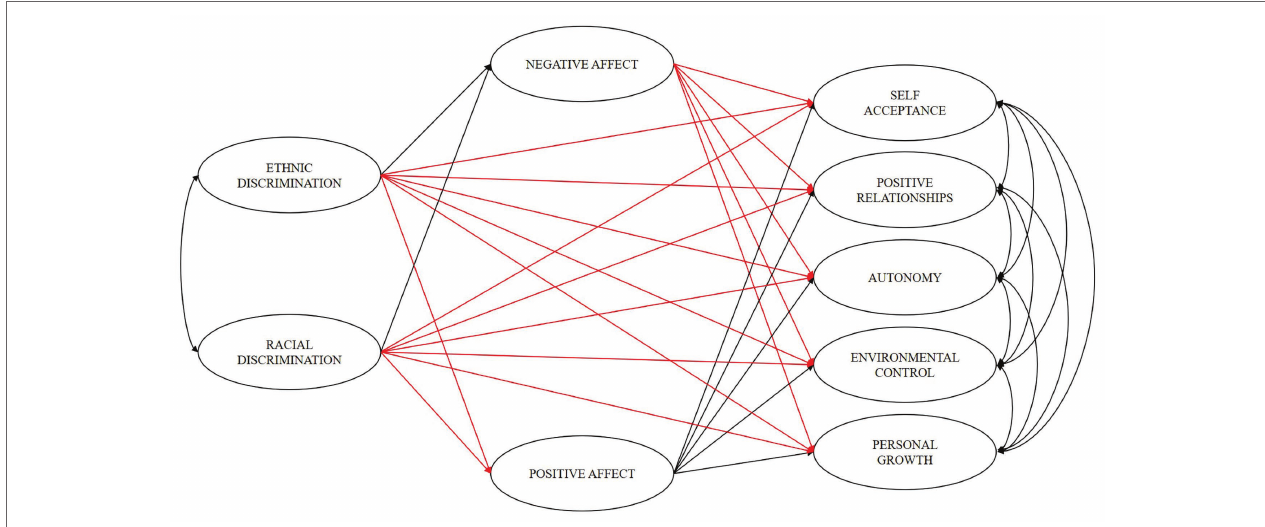
FIGURE 1 | Hypothetical model. Positive affects are shown in black and negative affects in